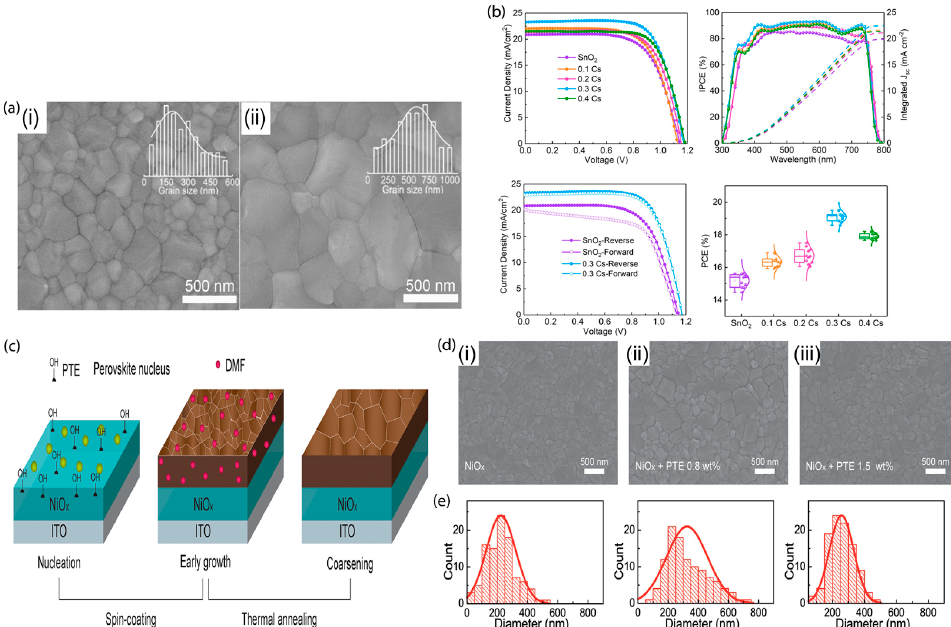
Figure 3. Correlation between grain size change and heterogeneous nucleation kinetics. Top-view SEM images of the perovskite films based on ( a ) ( i ) pristine and ( ii ) 0.3 Cs-treated SnO 2 films (scale bar is 500 nm). The insets show the statistical grain size distribution. ( b ) Device performance for different concentration of Cs doping in SnO 2 [80]. ( c ) Schematic diagram presenting nucleation and crystal growth via spin coating and thermal annealing process. ( d ) Top-view SEM images (scale bar is 500 nm) for MAPbI 3 with ( i ) pristine NiOx as HTL, ( ii ) NiOx as HTL with 0.8 wt% PTE, and ( iii ) NiOx as HTL with 1.5 wt% PTE and corresponding ( e ) histograms of grain size distribution for MAPbI 3 with NiOx and NiOx with different solution concentrations (0.8 and 1.5 wt%) of PTE as HTL [81]. Reprinted with